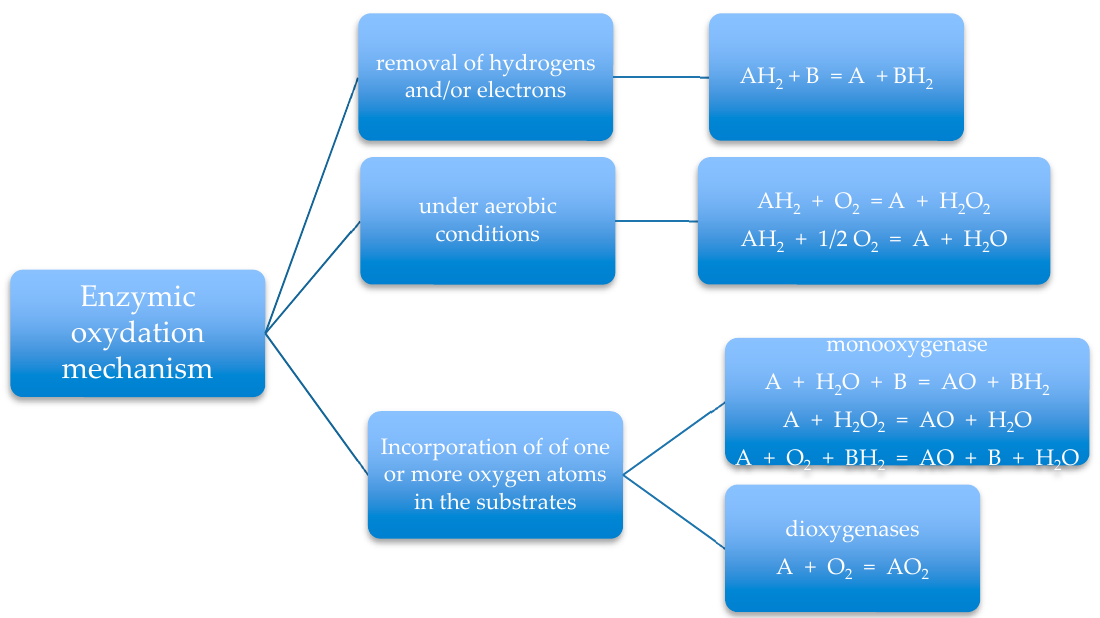
Figure 4. Enzymic oxidation mechanism. B, O 2 and H 2 O 2 are the electrons acceptors.